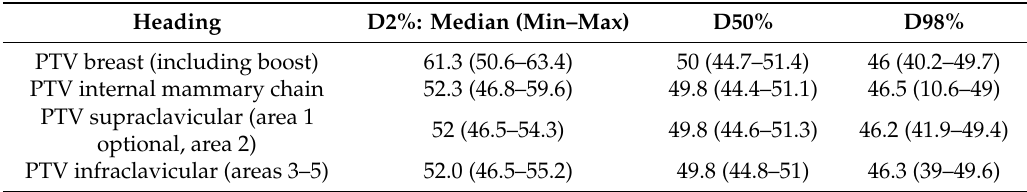
Table 2. Doses delivered to target volumes.